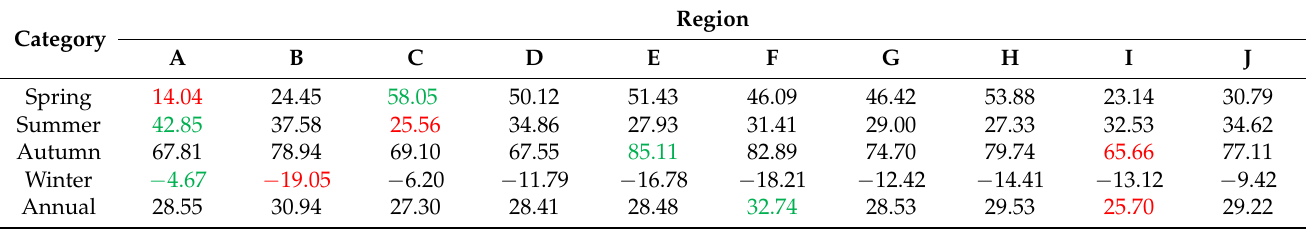
Table 15. Annual and seasonal energy savings in cases without louvers and with optimal